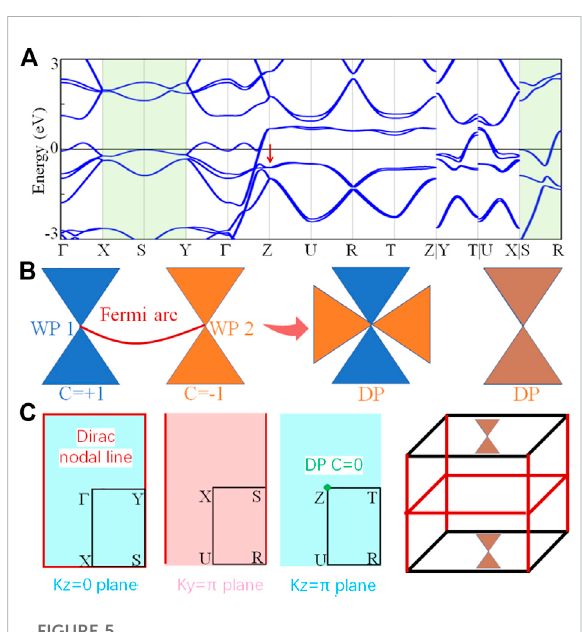
FIGURE 5 (A) Electronic band structures with SOC for LiRuO 2 compound. (B) Schematic diagram of a pair of Weyl points with opposite chirality and Dirac point. Among them, the two Dirac points are formed by four single bands and two double degenerate bands. (C) Different surfaces of LiRuO 2 in momentum space, where these red lines and green dot represent the node lines and Dirac point,